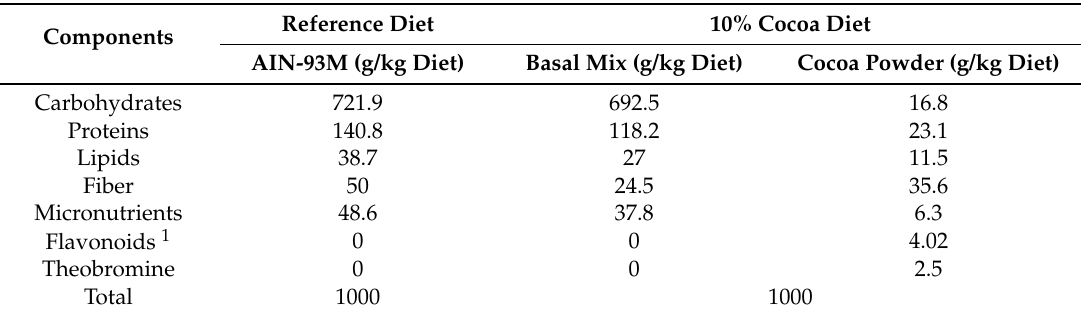
Table 2. Composition of the